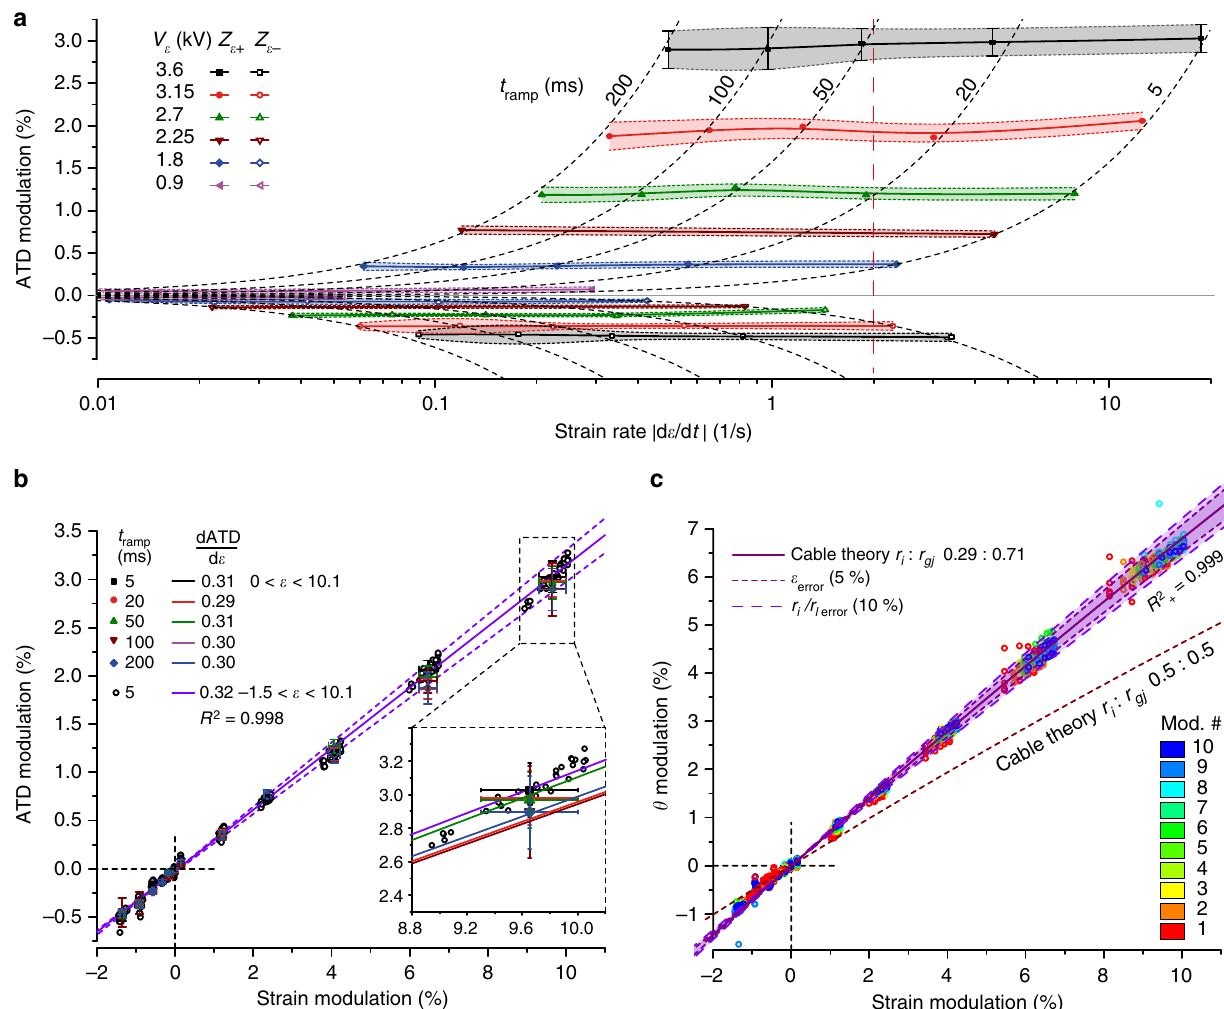
Fig. 5 Effects of increasing strain rates and strain amplitude on impulse conduction. a Modulation of activation time differences (ATDs) measured across the Z ε + region (above horizontal line) and Z ε − region (below horizontal line) as a function of maximal strain rates and amplitudes. The shaded area (extrapolated as a B-spline from the individual measurements) illustrates the extent of creep. The dotted lines depict identical ramp times (ATD = α ε t ramp d ε /d t ). b ATD modulation as a function of strain amplitude and strain rates. ATD modulation correlates linearly with strain amplitude (slope α = 0.30 ( ε > 0) and α = 0.32 (all strain values)). The inset referring to the data obtained at largest strain amplitudes demonstrates that the slope is not dependent on strain rate ( α mean = 0.302, α st.dev = 0.008). Horizontal error bars denote variations of strain amplitudes over multiple modulations, vertical error bars denote variations of ATDs at given strain amplitudes caused by creep. c Dependence of the impulse conduction velocity, θ , on strain amplitude. Circles denote results obtained during a complete set of experiments consisting of 10 successive strain cycles. All data were obtained from a single preparation. For further experiments cf. Supplementary Fig. 13. Source data are provided